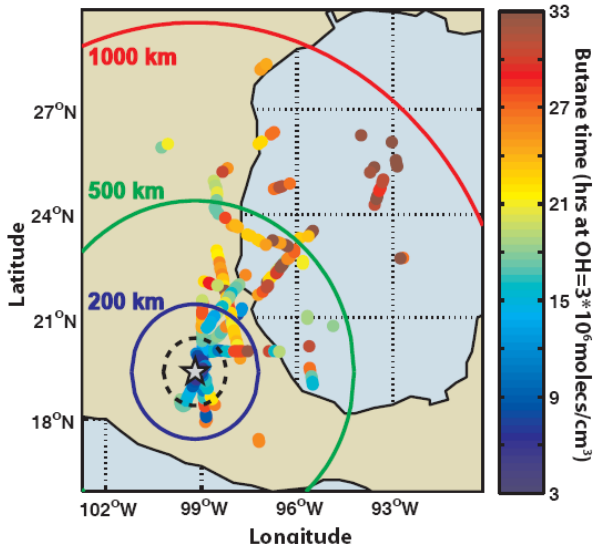
Figure 2) Locations of data that trace back to the region around Mexico City colored by 671 Fig. 2. Locations of data that trace back to the region around Mex- their photochemical age in hours of processing at OH=3*10 6 molecules/cm 3 . The black 672 ico City colored by their photochemical age in hours of processing star represents the location of Mexico City and the dashed black circle shows the limit of 673 at OH=3 × 10 6 molecules/cm 3 . The black star represents the loca- tion of Mexico City and the dashed black circle shows the limit of the region we have defined as the Mexico City Area (within 100 km of the city center). 674 the region we have defined as the Mexico City Area (within 100km The colored circles represent distances from the center of Mexico City of 200 km (blue), 675 of the city center). The colored circles represent distances from 500 km (green) and 1000 km (red). 676 the center of Mexico City of 200km (blue), 500km (green) and 1000km (red).